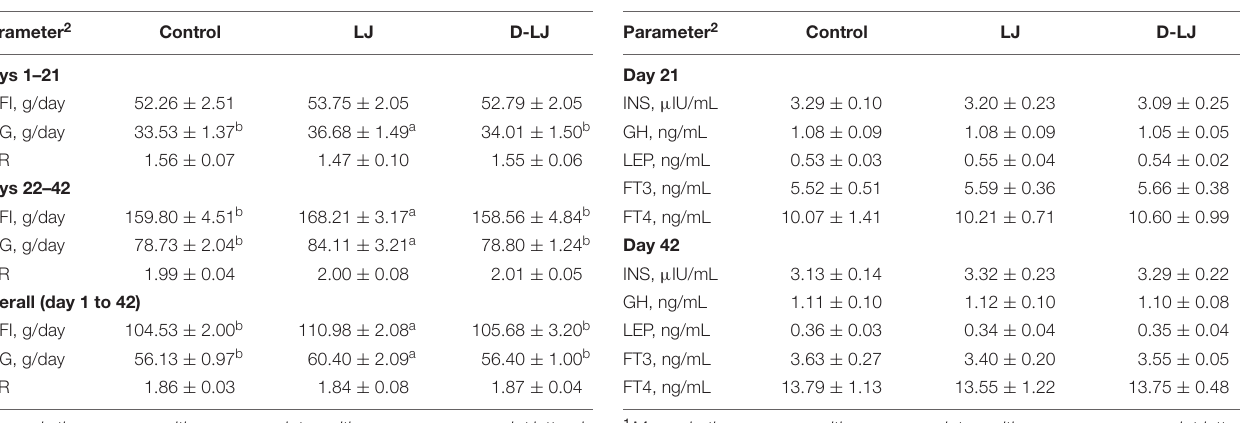
TABLE 4 | Effects of L. johnsonii BS15 on chicken growth performance 1 . TABLE 5 | Effects of L . johnsonii BS15 on serum hormone levels 1